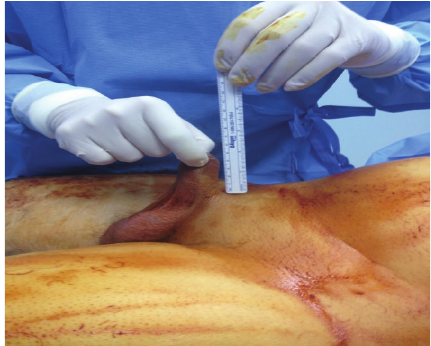
Figure 3: The distal penile skin dissected.